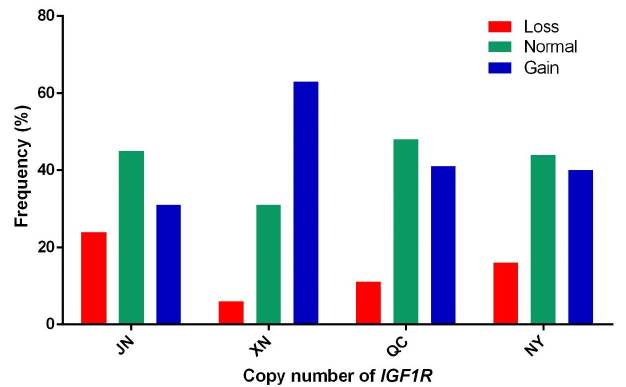
Figure 2. Copy number distributions of IGF1R in four Chinese cat- tle breeds. Histograms show the frequency of individuals with a dif- ferent copy number type of the IGF1R gene. Copy numbers were rounded to the nearest